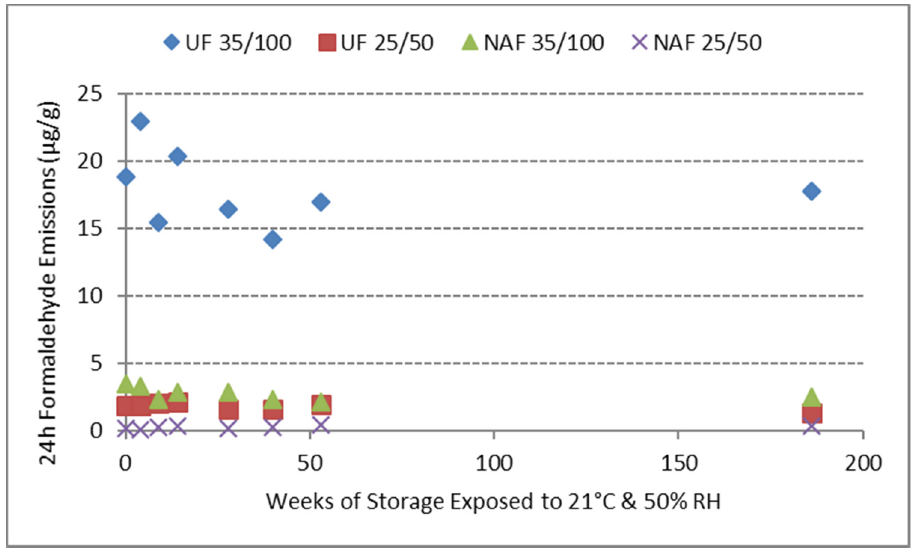
Figure 4. Formaldehyde emissions (ug/g dry wood) as a function of storage time.